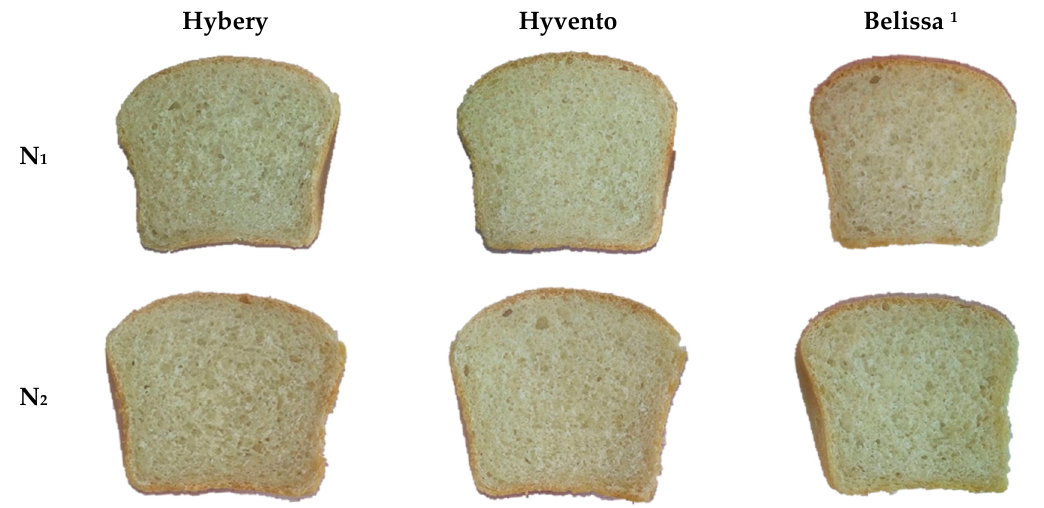
Figure 1. Crumb porosity of bread obtained from the flours of selected wheat cultivars with various levels of fertilisatio: N 1 .—110 kg / ha, N 2 —150 kg / ha. 1 Population cultivars. Table 5. Individual values of correlation matrix.